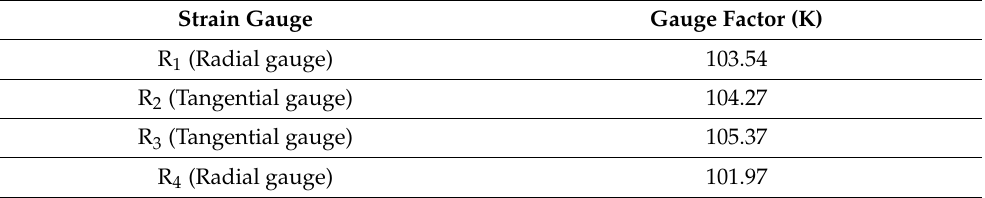
Table 2. Summary of the sensitivity of tangential and radial gauges according to Equation